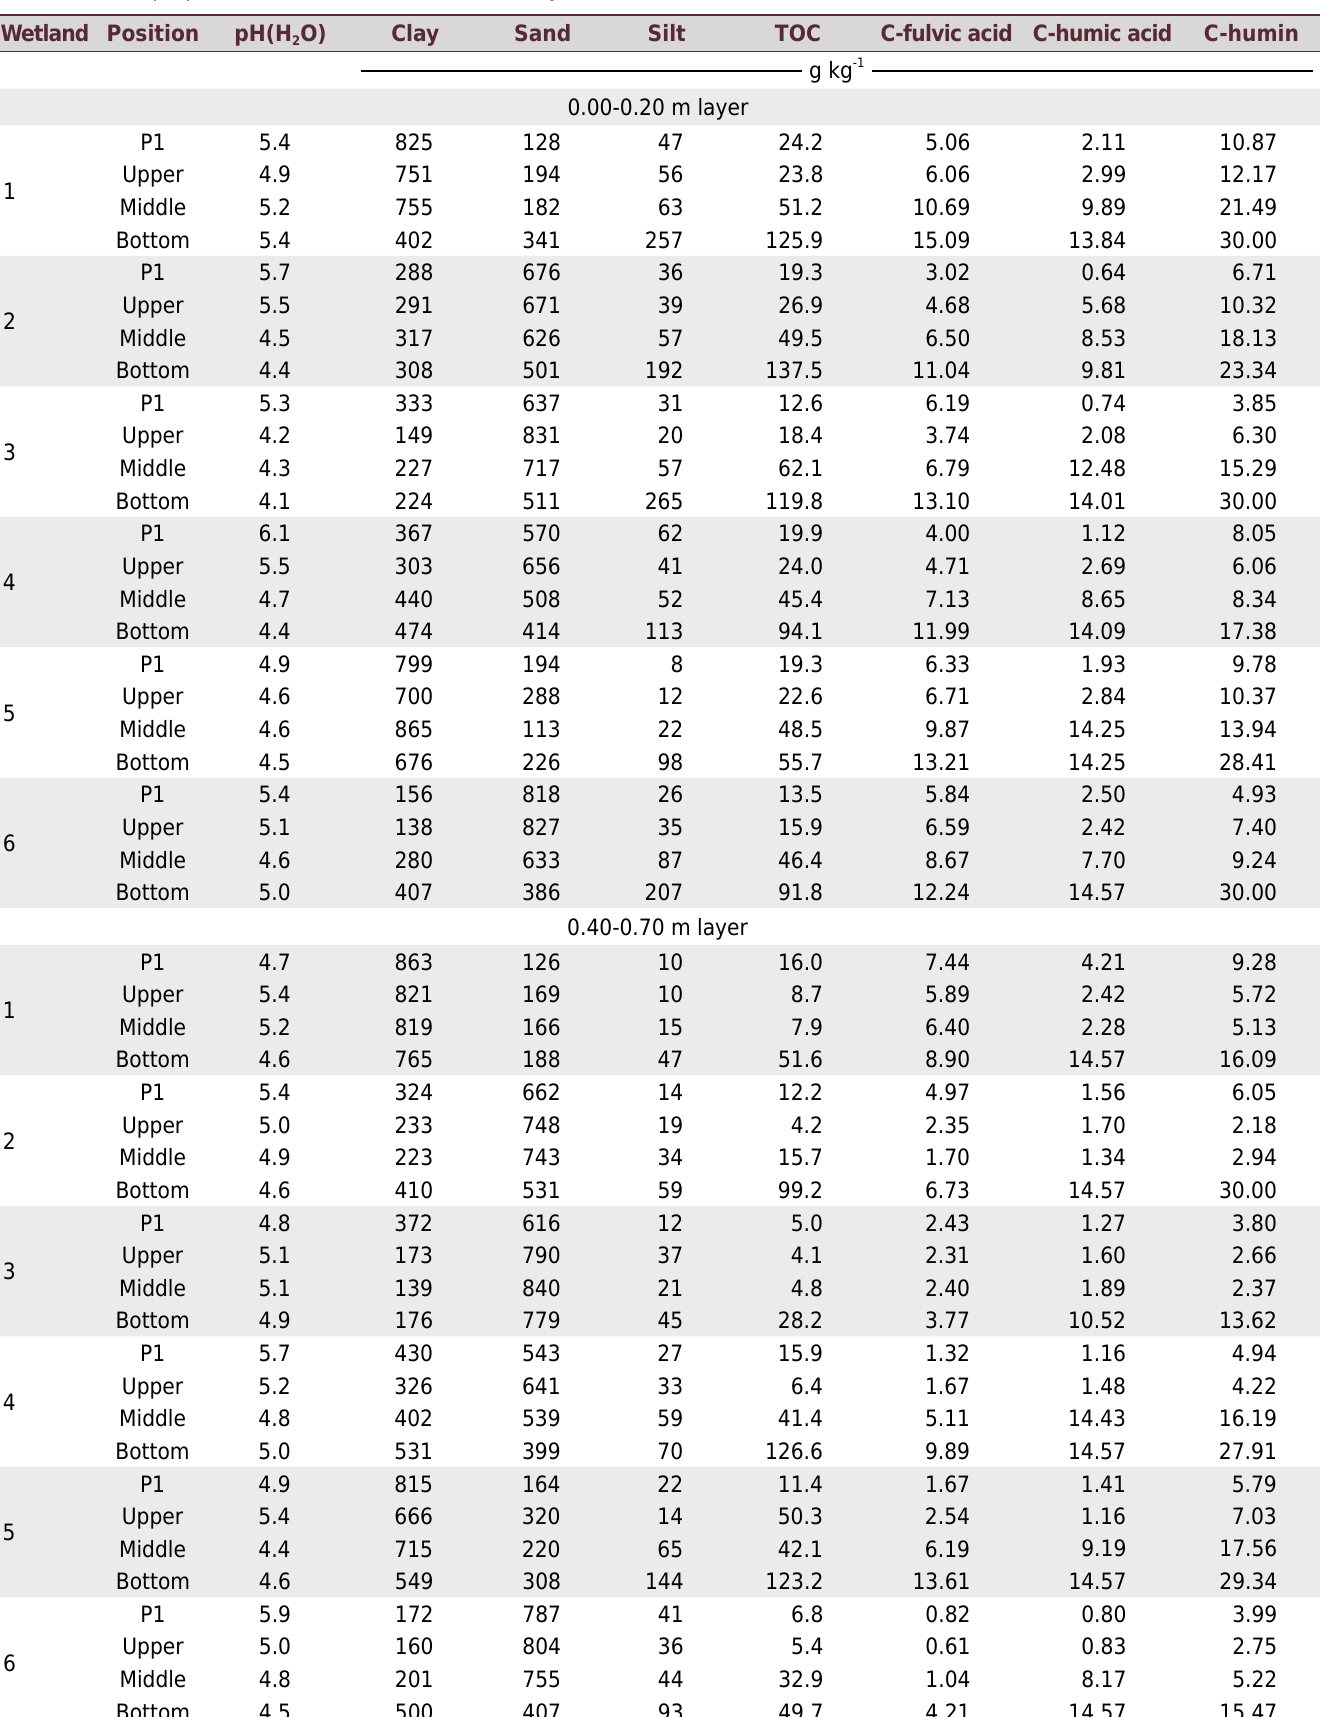
Table 1. Some properties of soils selected for the study Wetland